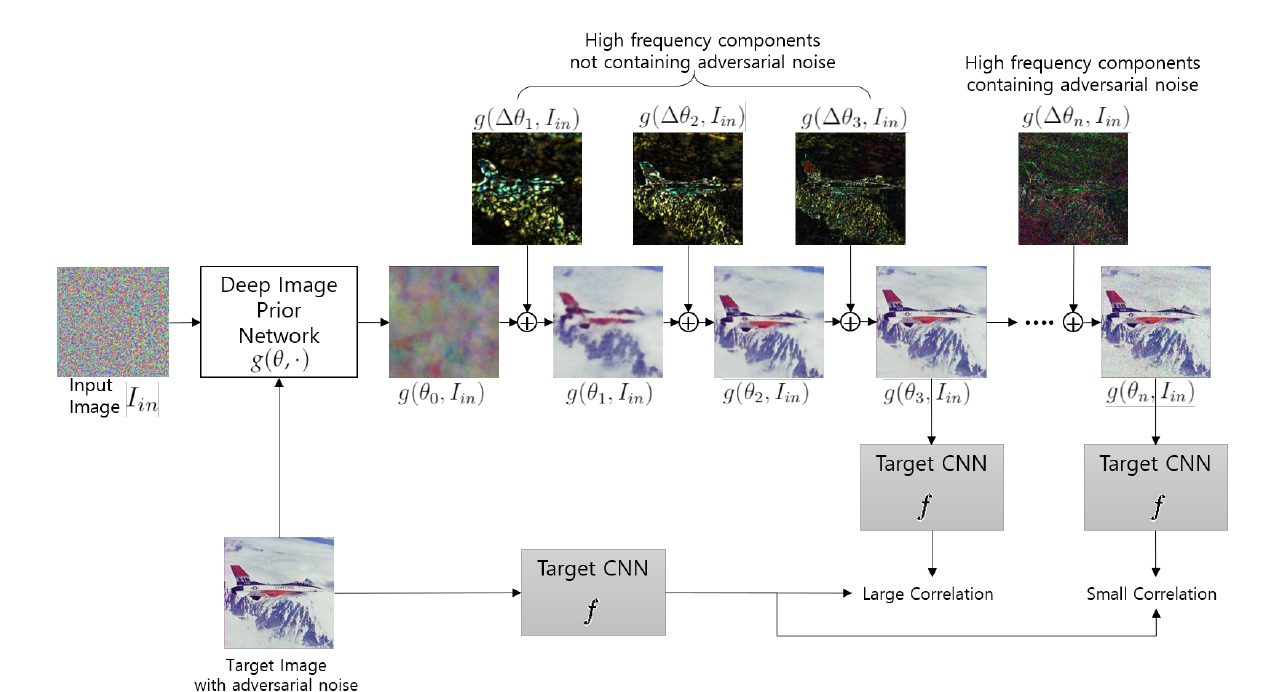
Figure 3. Concept of the proposed method.